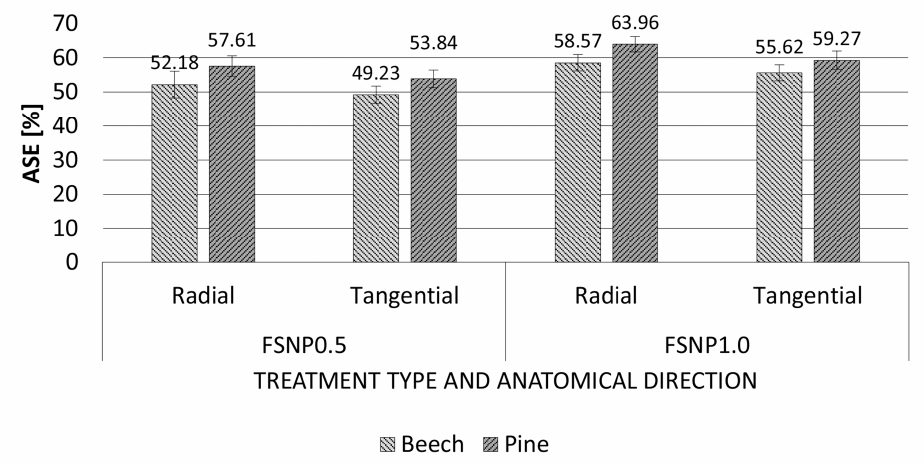
Figure 6. ASE of FSNP-modified beech and Scots pine wood in radial and tangential directions (whiskers show standard deviation of the results).